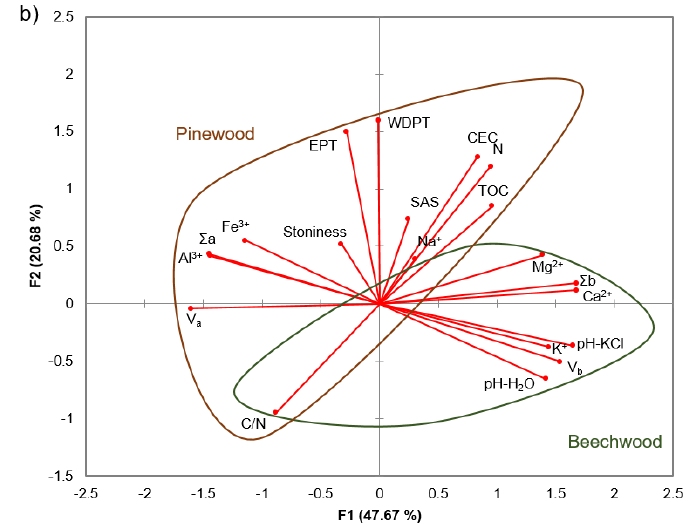
Figure 5. Principal component analysis (PCA) of the soil samples ( a ) and soil properties ( b ). In figure b), the abbreviations refer to: Soil Aggregate Stability (SAS), Water Drop Penetration Time (WDPT) and Ethanol Percentage Test (EPT), actual pH (pH-H 2 O) and potential pH (pH-KCl), total organic C (TOC), total N (N), soil C/N ratio (C/N), exchangeable basic cations (Ca 2+ , Mg 2+ , Na + , K + ), exchangeable acid cations (Fe 3+ , Al 3+ ), sum of basic (Σb) and acid (Σa) cations, cation exchange capacity (CEC), bases (Vb), and acid (Va) saturation.